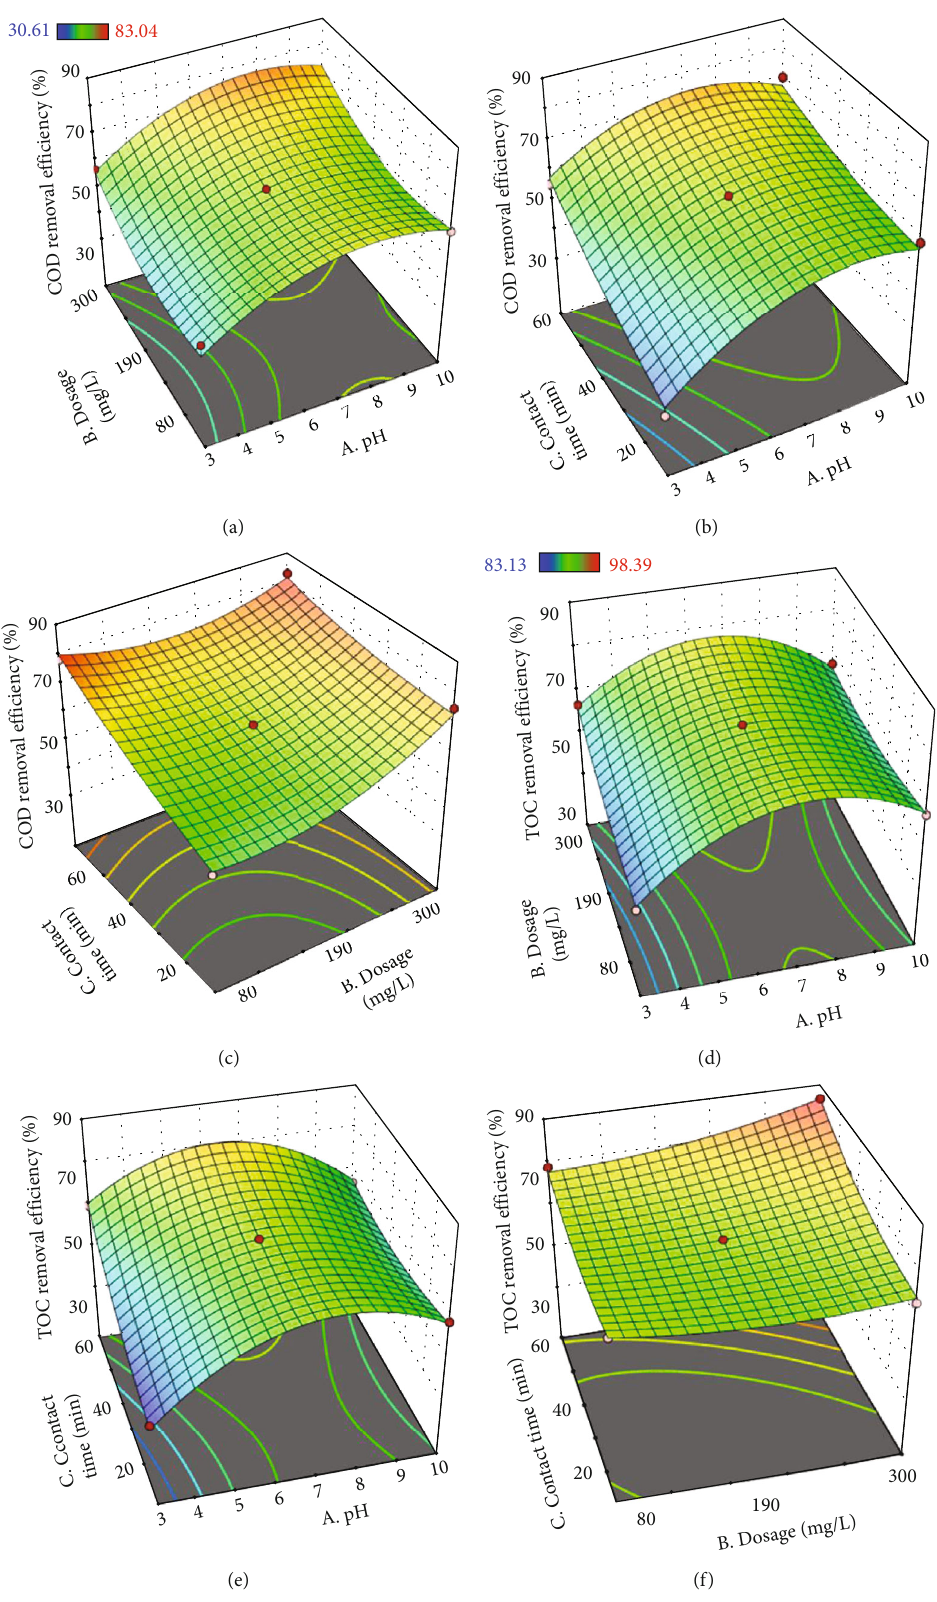
Figure 7: Surface plots for COD and TOC removal e ffi ciencies using RSM (a) pH ~ dosage ~ COD removal e ffi ciency (b) pH ~ contact time ~ COD removal e ffi ciency (c) dosage ~ contact time ~ COD removal e ffi ciency (d) pH ~ dosage ~ TOC removal e ffi ciency (b) pH ~ contact time ~ TOC removal e ffi ciency (c) dosage ~ contact time ~ TOC removal e ffi